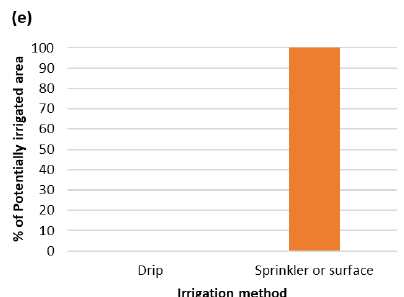
Figure 11. Percentages of High Risk of Sodification areas per slope class ( a ), drainage class ( b ), soil reference group ( c ), land occupation ( d ) and irrigation method ( e ). LP—Leptosols; LV—Luvisols;